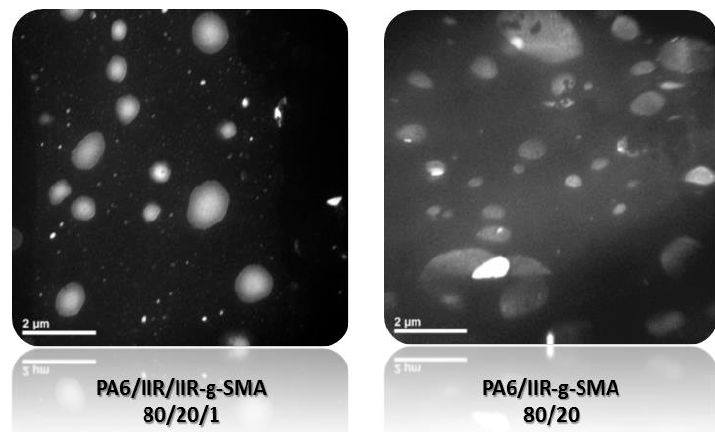
Figure 7. TEM photomicrographs of blends of PA-6/IIR/IIR- g -SMA (80/20/1 wt. ratio, left ) and PA-6/IIR- g -SMA (80/20 wt %, right ). Magnification used: 30,000 ×. The polyamide phase is stained dark with phosphotungstic acid.